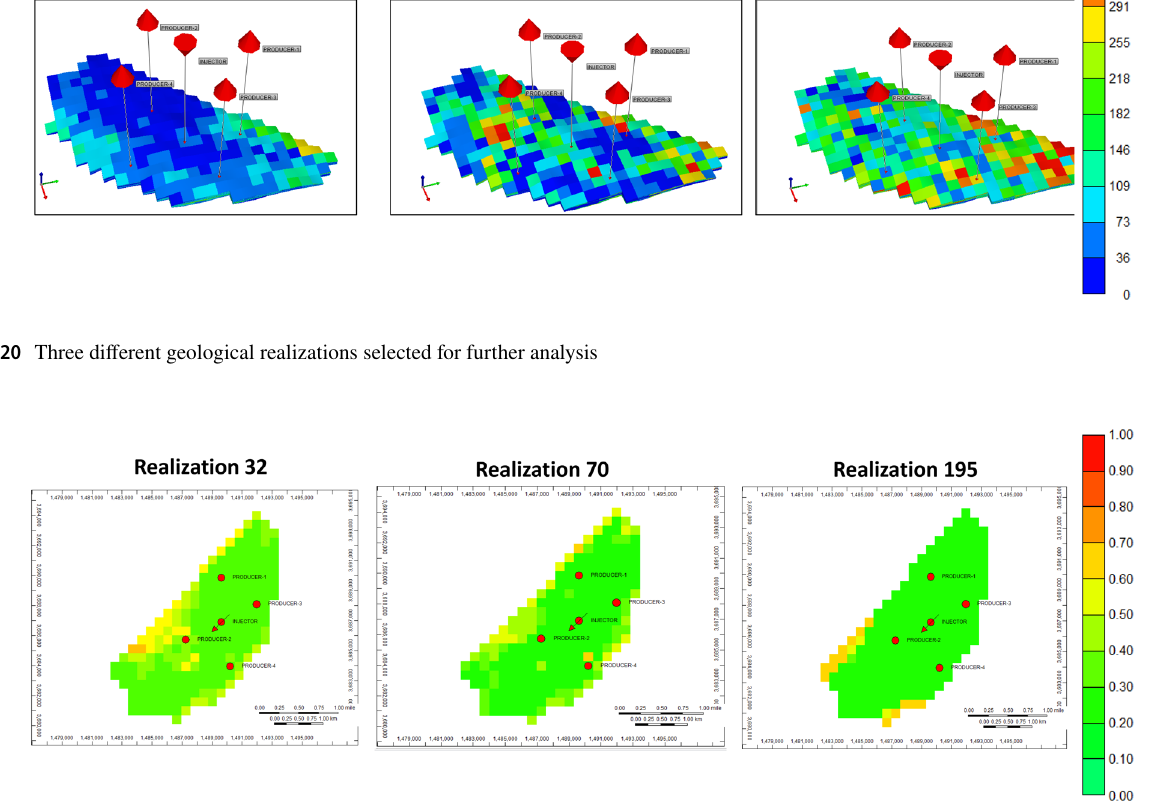
Fig. 21 Residual oil saturation maps for three selected realizations (32, 70 and